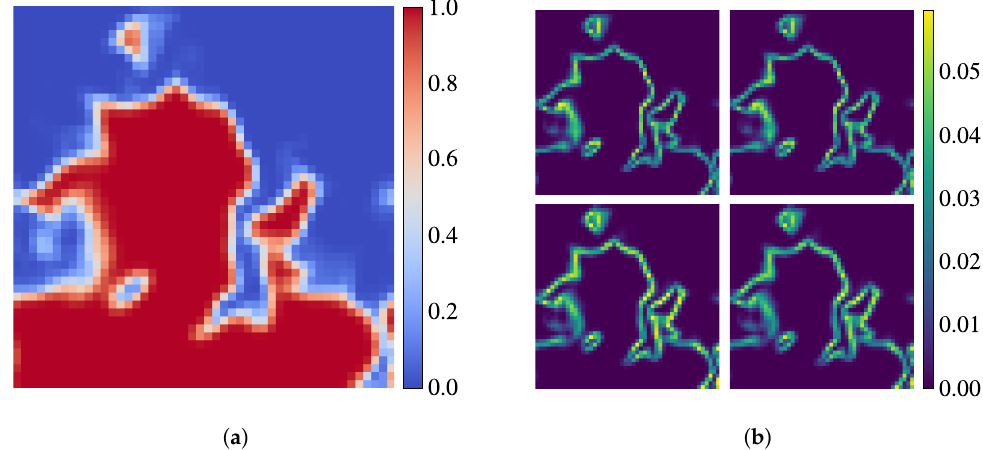
Figure 5. Sample slices of c ( a ), and c (cid:48) 2 ( b ): ground truth (top-left), CNN (top-right), CST (bottom-left), and DYN (bottom-right) model on the HIT test set.